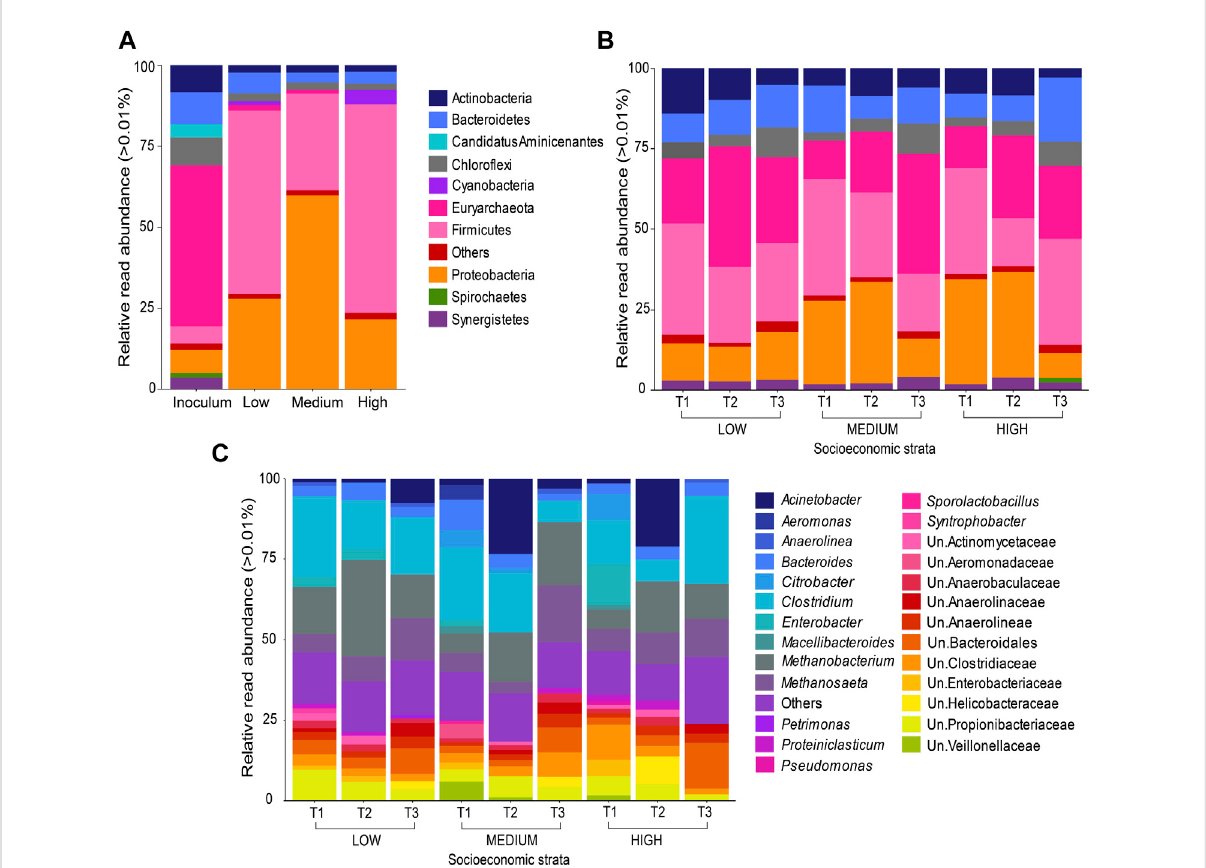
FIGURE 5 Relative read abundance of the most abundant bacteria and archaea: (A) at the phylum-level for the OFMSW substrates from the three socioeconomicstrataandfortheinoculumusedintheBMPassays; (B) atthephylum-levelfortheOFMSWsubstratesfromthethreesocioeconomic strata at timepoints T1, T2 and T3; (C) at the genus-level for OFMSW substrates from the three socioeconomic strata at timepoints T1, T2 and T3. ANOSIM = 0.4226, Signi fi cance =